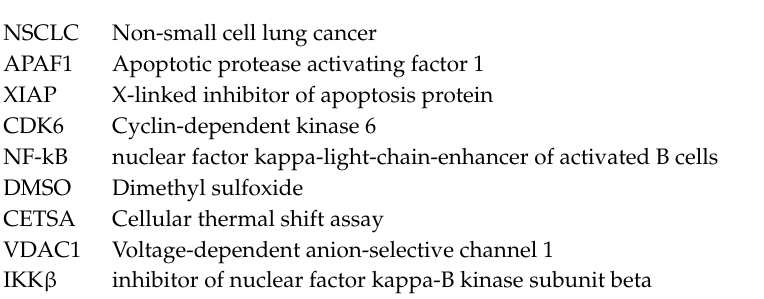
Figure S1: RMSF plot of Bcl2 (Black) and Bcl2-ligand complex (Red), Figure S2: Secondary structure of Bcl2, Figure S3: Secondary structure of Bcl2-ligand, Figure S4: Western blot images with molecular weight for CDK6, CyclinD1, BCL-2, Bcl-XL, Mcl-1, XIAP, Bax, Bid and respective β -actin control bands shown in Figures 4G and 5A Figure S5: Western blot images with molecular weight for Cytochrome-C, VDAC1, Caspase-9, Caspase-3, APAF1 and the respective β -actin control bands shown in Figure 5D,E, Figure S6: Western blot images with molecular weight for PARP1, c-Myc, p53, IL-4, IL-6, NF-kB, IKK β and the respective β -actin control bands shown in Figure 5F. The red dotted rectangle indicates the area shown in Figure 5F, Figure S7: Inhibition of Bcl-2 protein in vivo and immunohistomistry study Table S1: List of